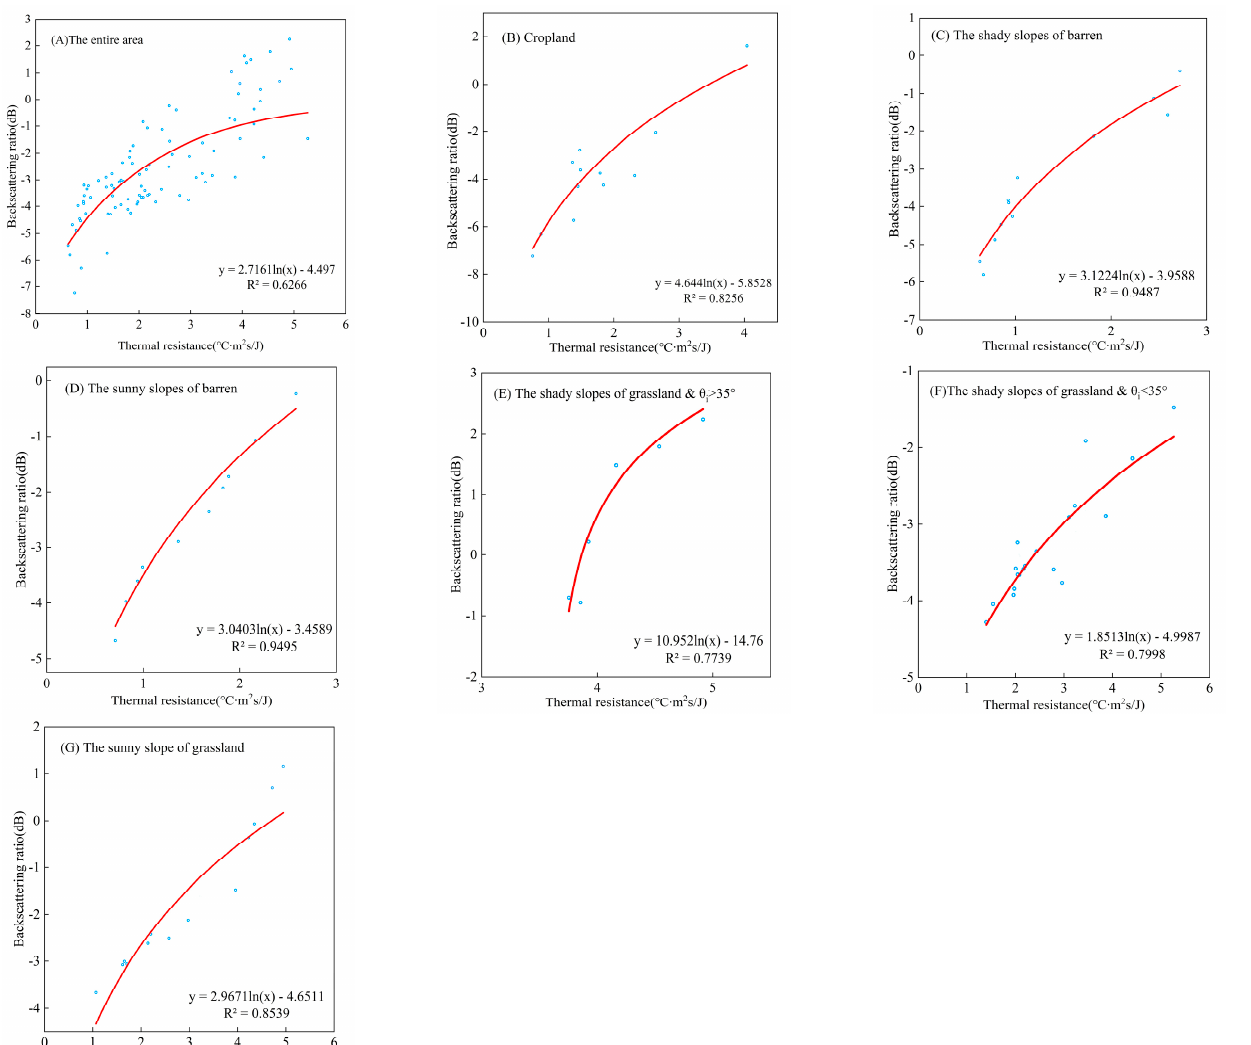
Table 4. Comparison of function fitting accuracy and parameters.